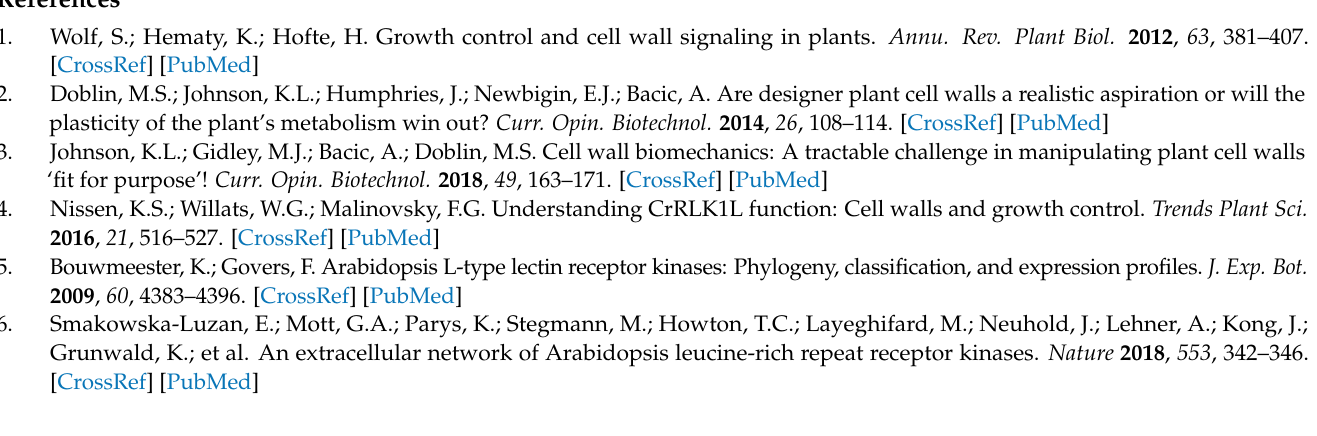
WAKL8 during development. Figure S2: Phloroglucinol-HCl staining of lignin in transverse sections 1 cm from the stem base of WT, wakl8-1 and wakl8-2 plants. Figure S3: Mäule staining of lignin in transverse sections 1 cm from the stem base of WT, wakl8-1 and wakl8-2 plants. Figure S4: Sequencing of alternative spliced versions of WAKL8